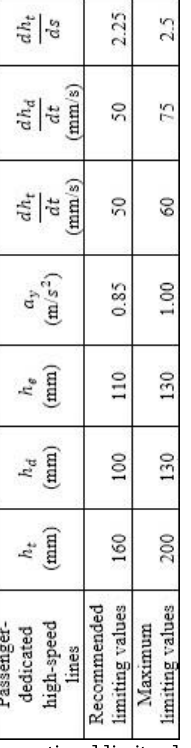
Table 1. Normal and exceptional limit values recommended by TSI and CEN standards (Lindahl, 2001).